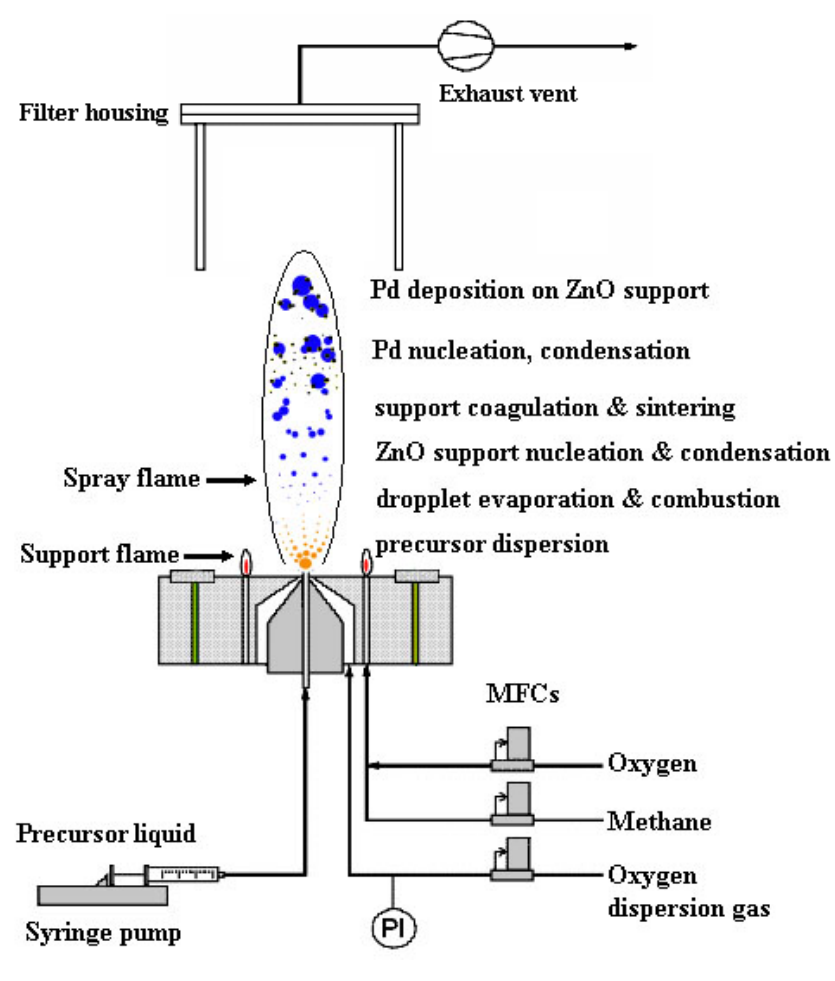
Figure 1. Schematic of the FSP experimental setup for the synthesis of samples P0-P5. The liquid precursor mixture is rapidly dispersed by a gas stream and ignited by a premixed methane/oxygen